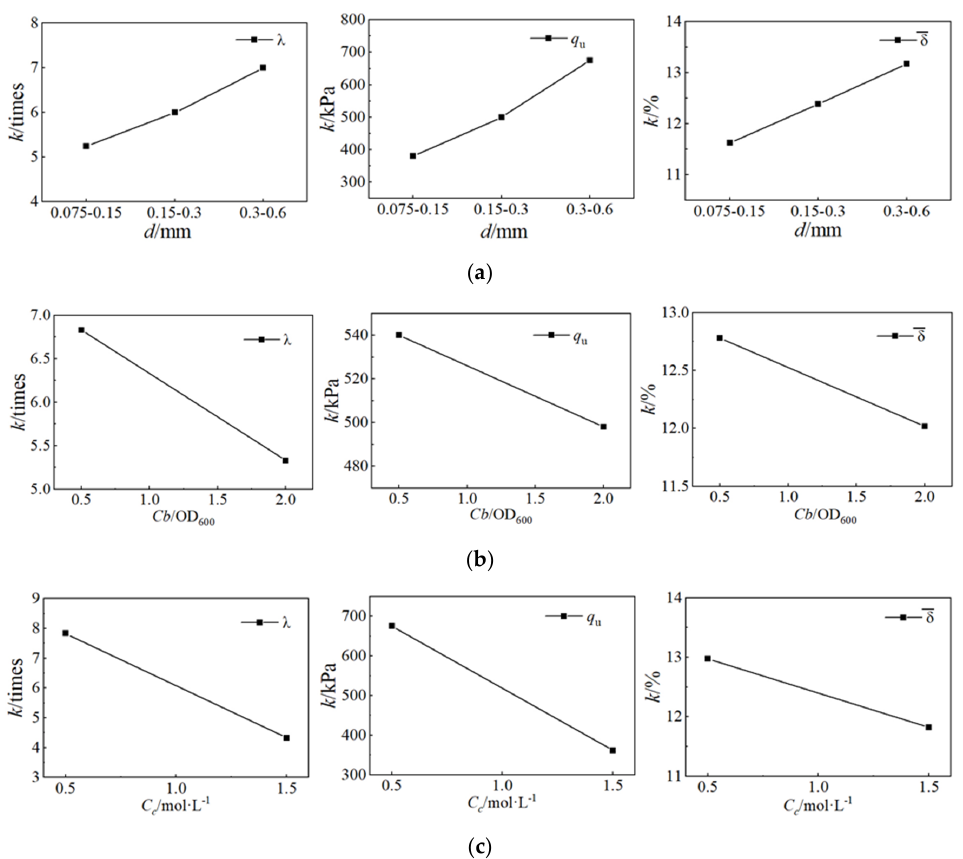
Figure 6. The variation pattern of k jm value of each test factor with level: ( a ) effects of sand particle size on test index; ( b ) effects of concentration of bacterial suspension on test index; ( c ) effects of concentration of cementation reagent on test index.